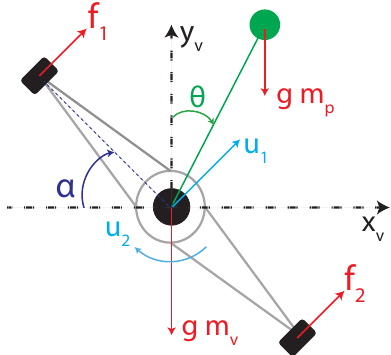
Figure 1. PVTOL aircraft system with an inverted pendular